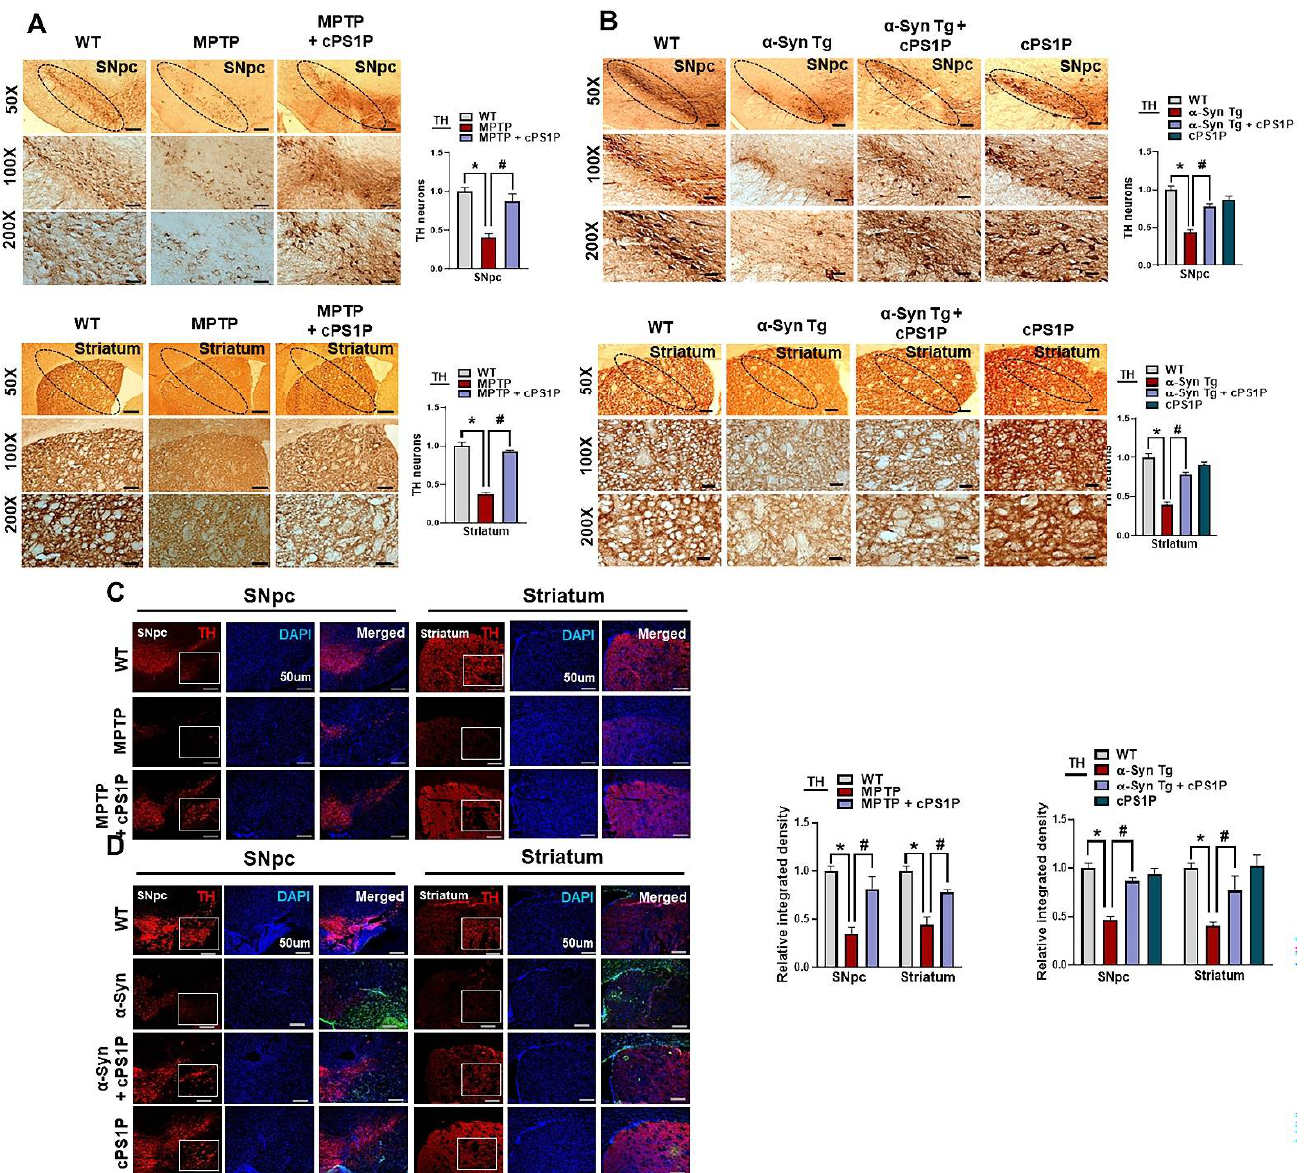
Figure 5. Immunostaining analysis of TH in the SNpc and striatum of MPTP and NSE-hαSyn PD mouse models. ( A , B ) Immunostaining of TH in the substantia nigra pars compacta (SNpc) and striatum of MPTP and NSE-hα S yn PD mouse models, respectively (n = 3 mice/group/model). ( C , D ) Immunofluorescence reactivity of TH in the SNpc and striatum of MPTP and NSE-hαSyn PD mouse models, respectively (n = 3 mice/group/model). The density values are relative to those of the control group and are expressed in arbitrary units (AU). Magnification 10x, scale bar = 50 µm. The values indicate the mean ± SEM. The significant differences have been given in the graphs. * Significant difference between the control and model group; # Significant difference between the model and cPS1P co-treated mouse. p < 0.05 was considered significant difference between the groups, as measured with one-way ANOVA followed by Tukey’s multiple comparison